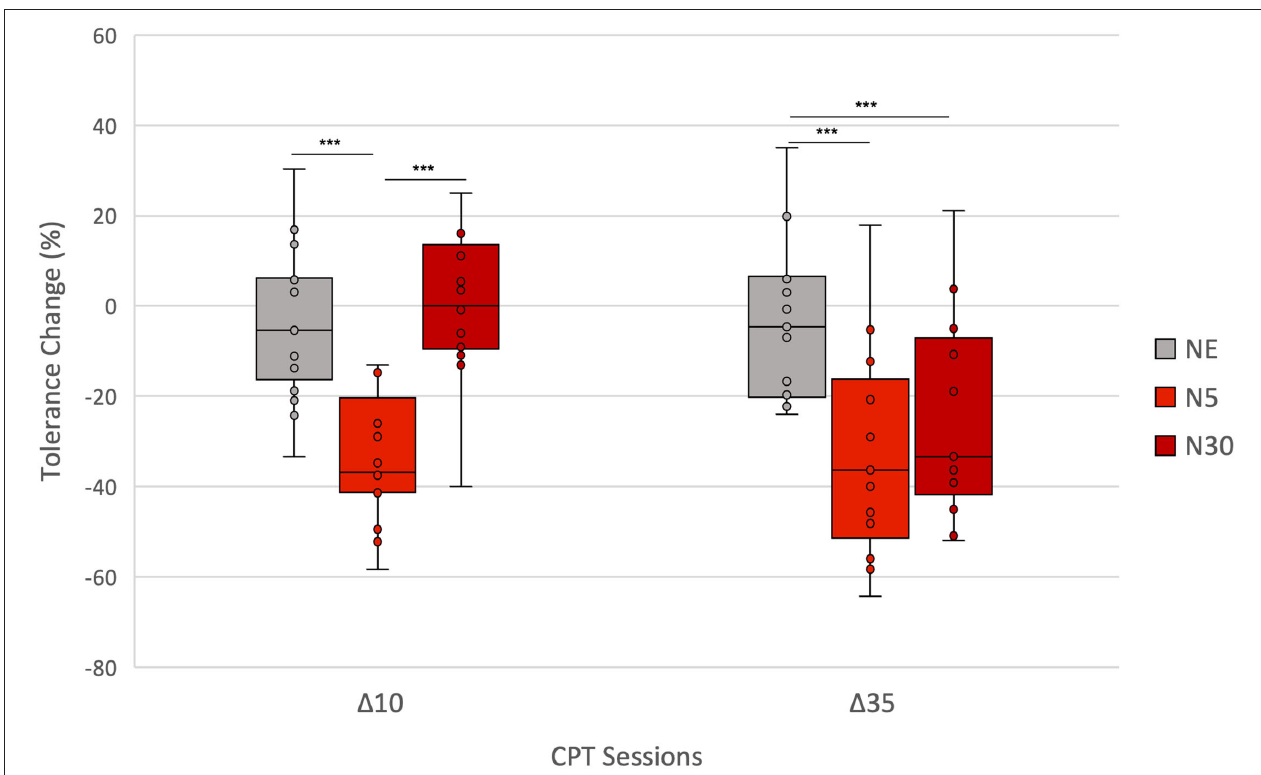
FIGURE 4 | Between-group comparison: Percent change in CPT tolerance from Baseline to Test 10 ( 1 10) and to Test 35 ( 1 35) for each group (NE, N5, N30). Asterisks indicate significant differences in 1 s between groups (* p < 0.05; ** p < 0.01; *** p < 0.001). 1 10 was significantly lower in N5 than in both NE and N30. 1 35 was significantly lower in both N5 and N30 compared to the NE group. The lowest and highest boundaries of the boxes indicate the 25th and the 75th percentiles, respectively. The black line within each box indicates the median. Whiskers above and below the boxes indicate the largest and the lowest data points (excluding any outliers), respectively.